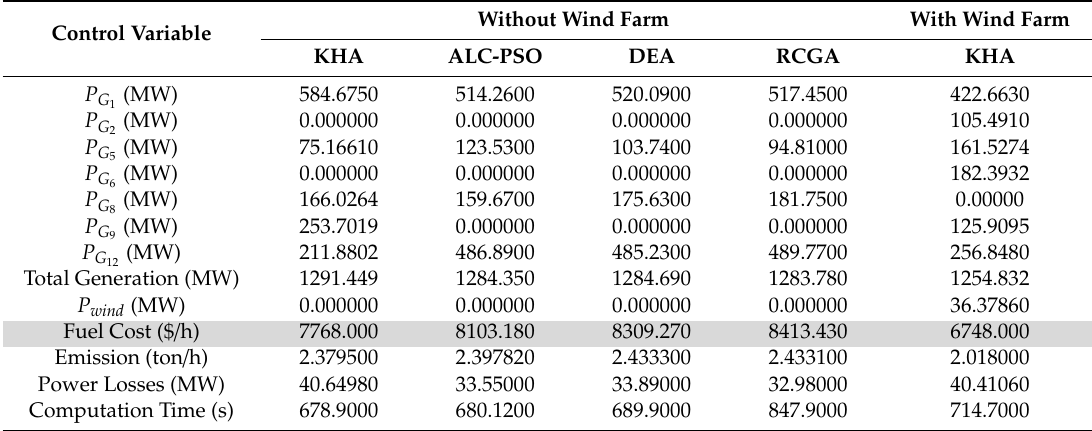
Table 8. Results for fuel cost minimization without considering the valve-point e ff ect for the Test System 2.